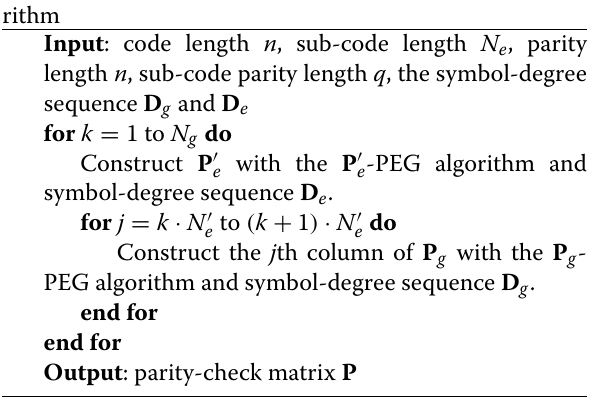
Algorithm 1 High-level description of PEG-LDMC algo-